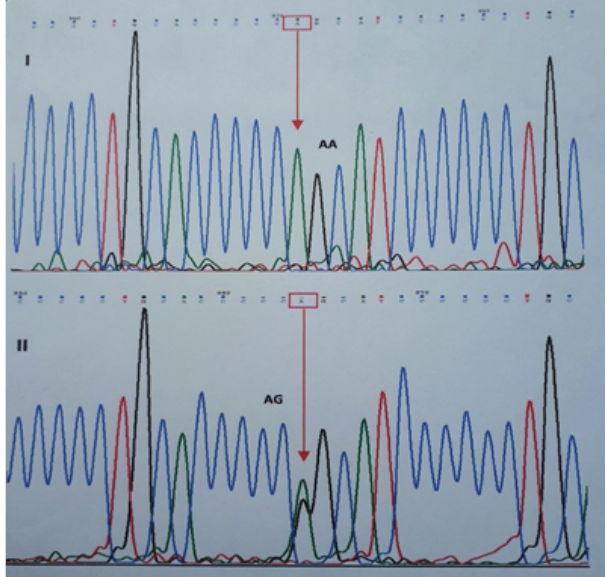
Figure 2. Section of the sequencing data surrounding the region of the Single Nucleotide Polymorphism rs25531. In diagram I (upper) the geno- type AA is represented only by the presence of the Adenosine peak, in green. Diagram II (lower) shows the presence of the Adenosine (green) and Guanine (black) peaks which